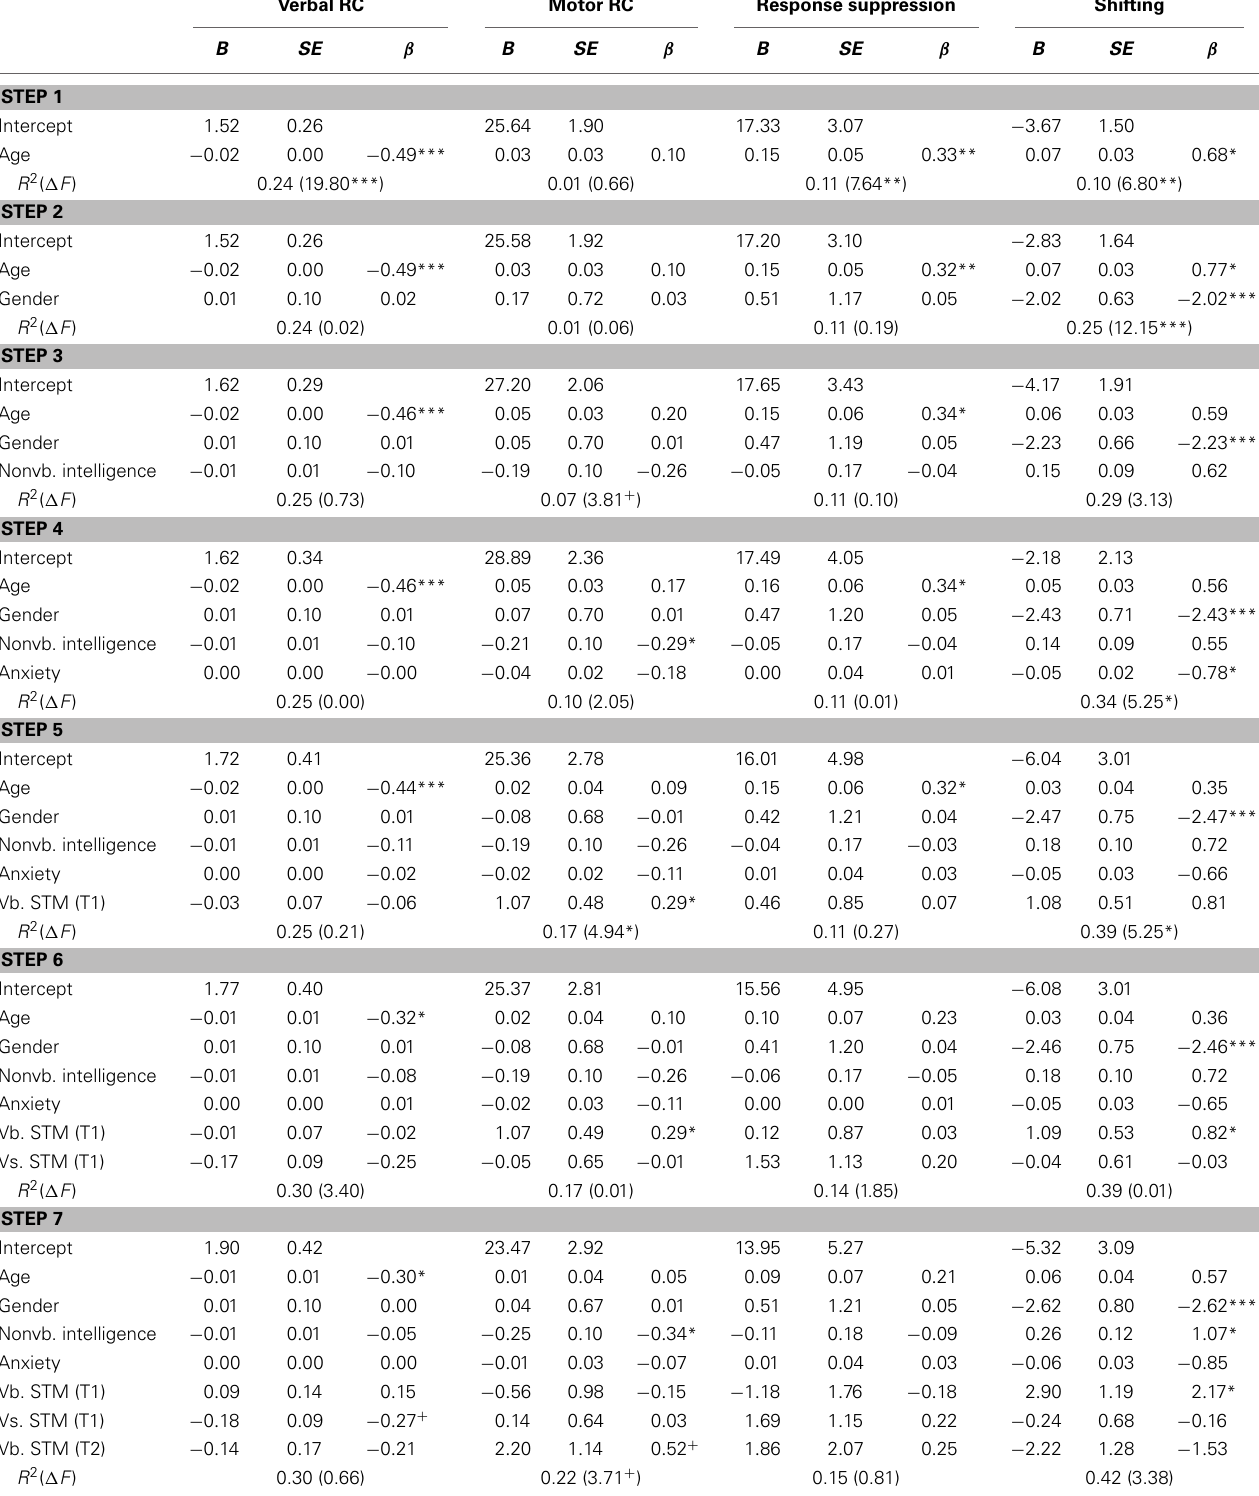
Table 3 | Hierarchical regression models predicting children’s performance on inhibition (verbal and motor response conflict, and response suppression) and shifting measures. Verbal RC Motor RC Response